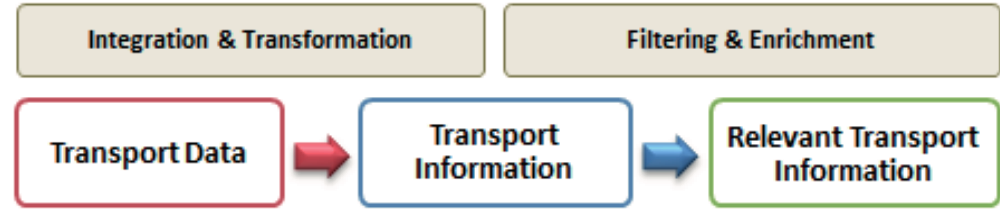
Figure 1. Evolution of transport